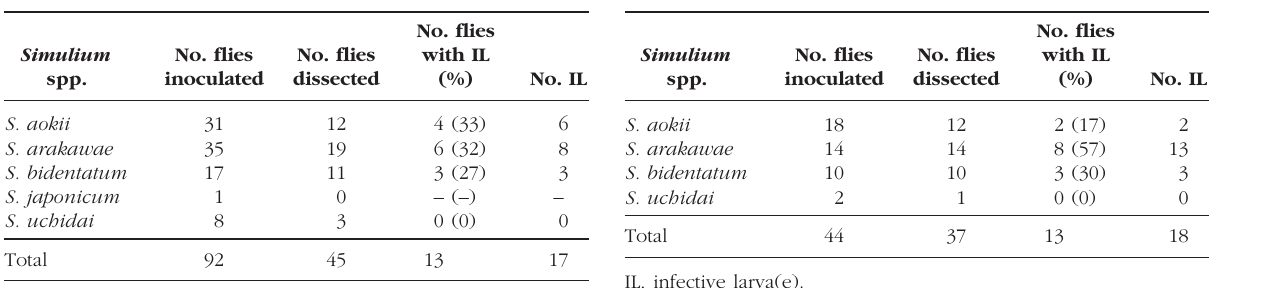
Table III. – Results of experimental infections of female Simulium species with Onchocerca skrjabini